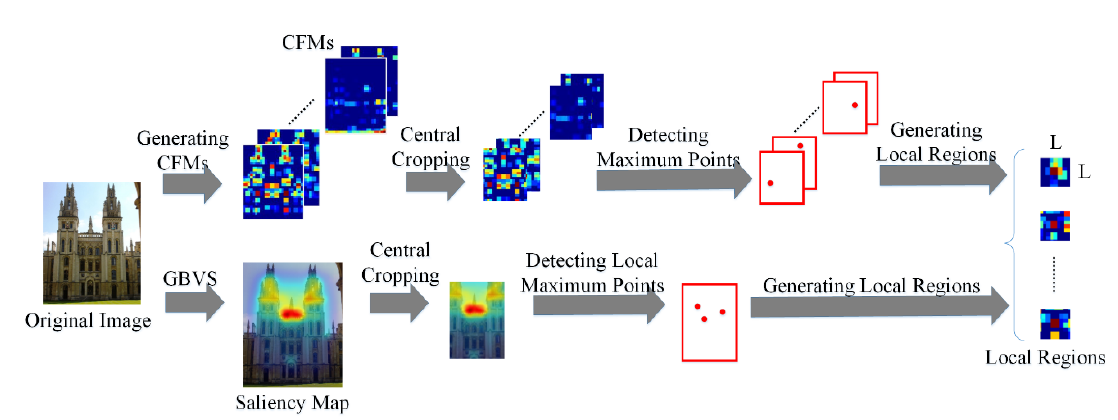
Figure 3. The flowchart of local region generation.